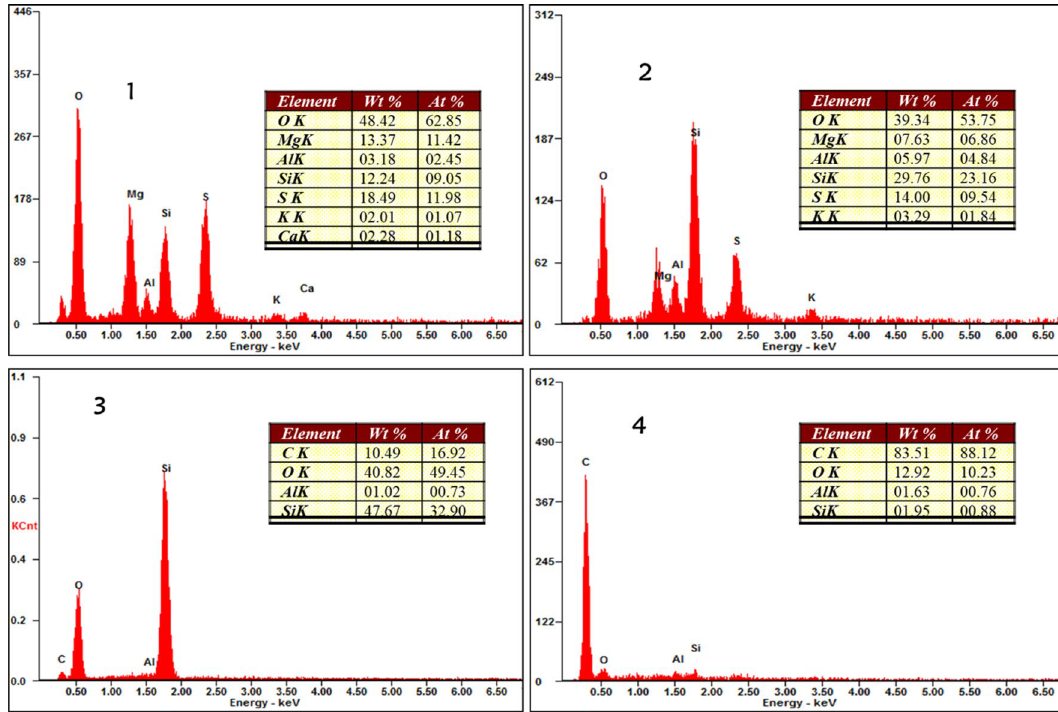
Figure 9. Point elemental analyses of sample with 10% bentonite.